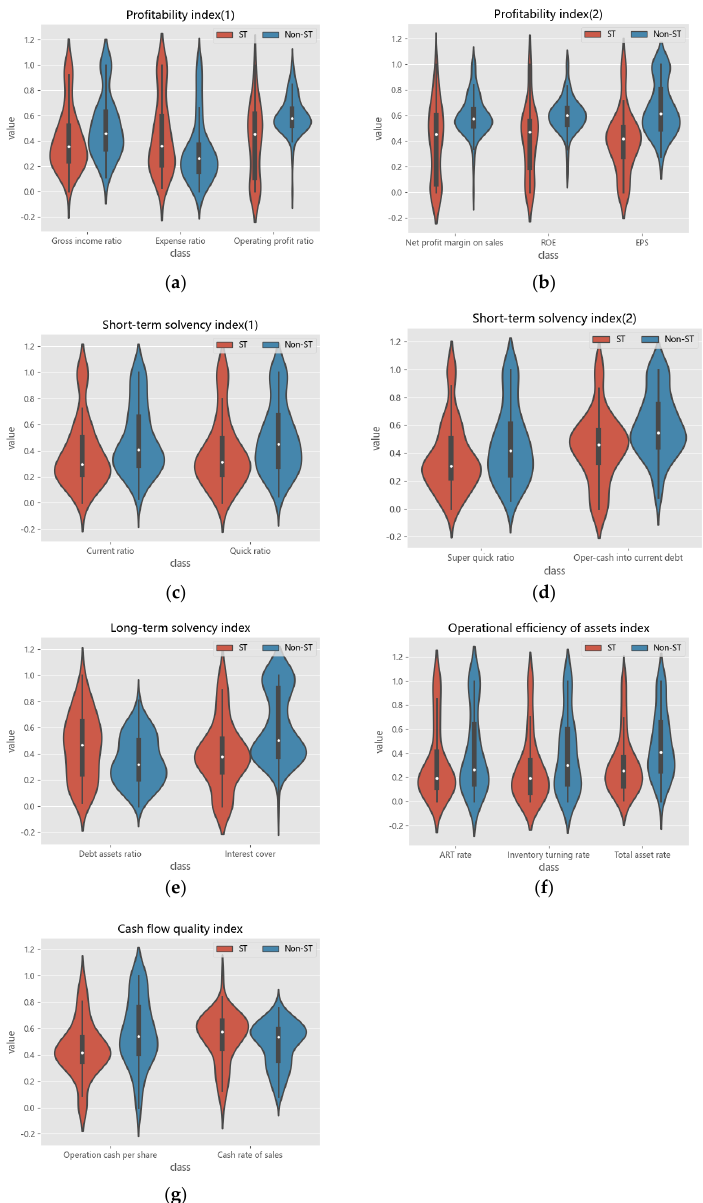
Figure 4. Violin chart based on the company’s financial indexes. ( a ) Profitability index (1); ( b ) Profitability index (2); ( c ) Short-term solvency index (1); ( d ) Short-term solvency index (2); ( e ) Long-term solvency index; ( f ) Operational efficiency of assets index; ( g ) Cash flow quality index.